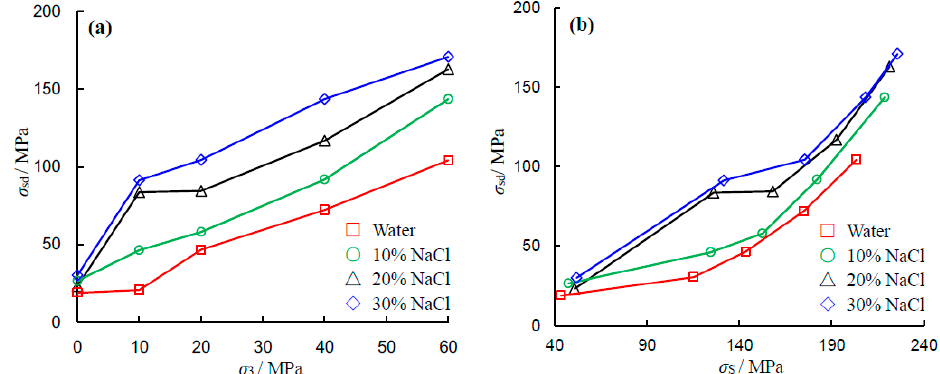
Figure 7. The influence of confining pressure and salinity level on crack damage stress of sandstone specimens. ( a ) Crack damage stress versus confining pressure; and ( b ) Crack damage stress versus peak strength. Note: σ sd = σ cd + σ 3 .